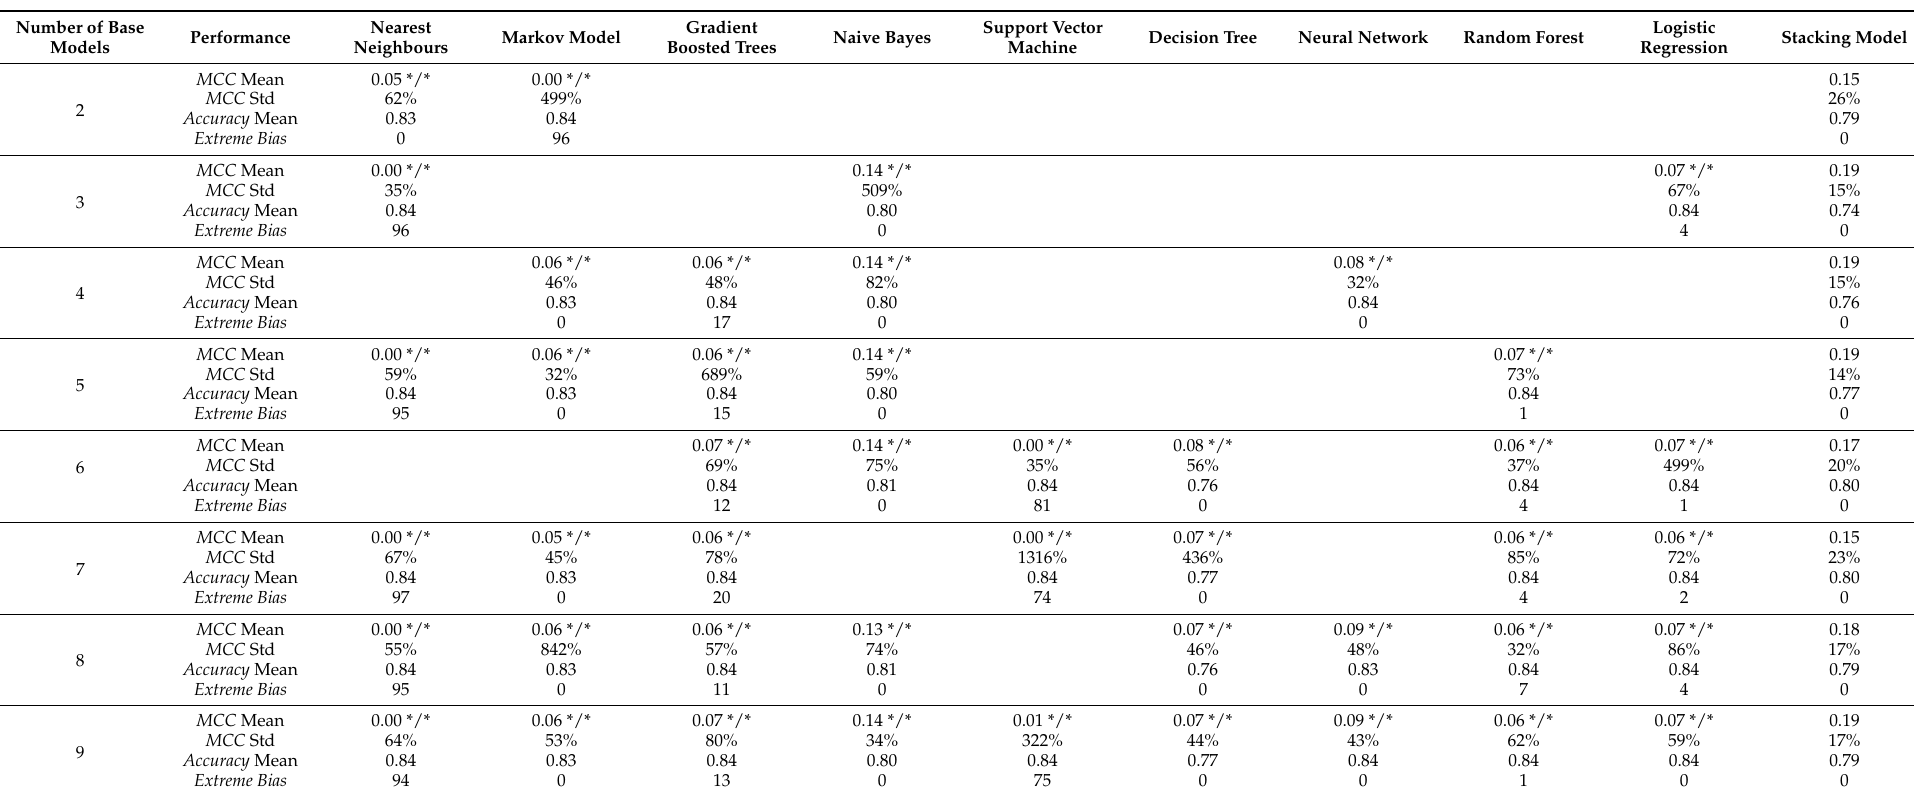
Table 2. Modeling Results for the Lending Club Peer-to-Peer Loans